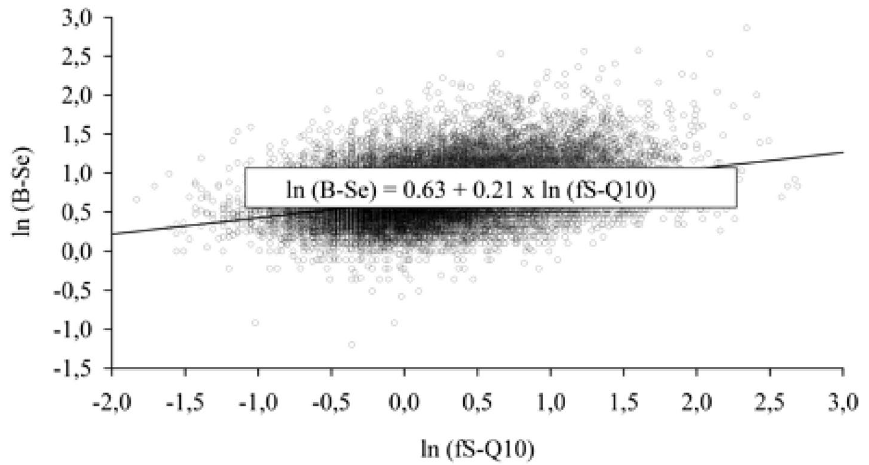
Figure 2. Scatter plot with regression line to illustrate the relationship between fS-Q10 and B-Se (R = 0.36, p < 0.001), both being logarithmically transformed. The results for children and adults are combined (n =